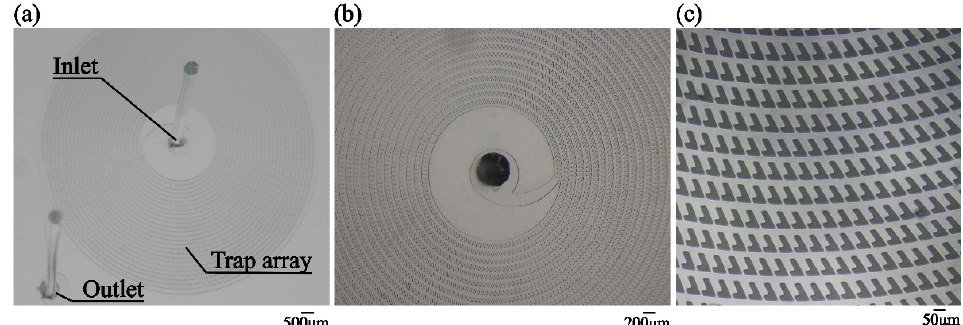
Figure 3. ( a ) Photo of the microfluidic pattern. ( b ) Microscopic image of the center of the microfluidic pattern. ( c ) Microscopic image of a group of cell traps.